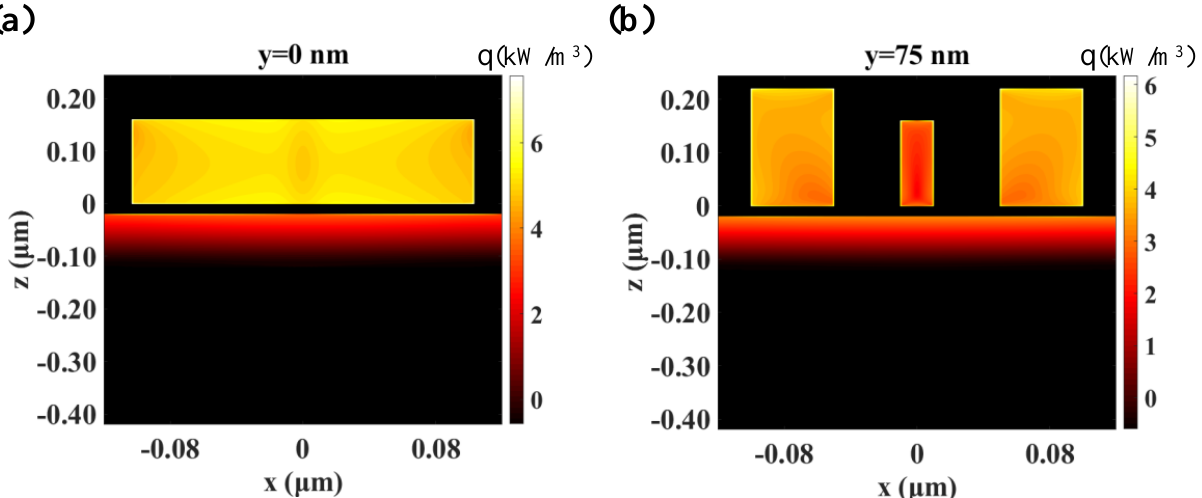
Figure 5. Power dissipation density distributions inside the absorber. ( a ) The power dissipation density in x – z plane at y = 0. ( b ) The power dissipation density in x – z plane at y = 75 nm. The wavelength is 2160 nm and the values of the power dissipation distributions in the figures are taken as the logarithm of the original values (log 10).